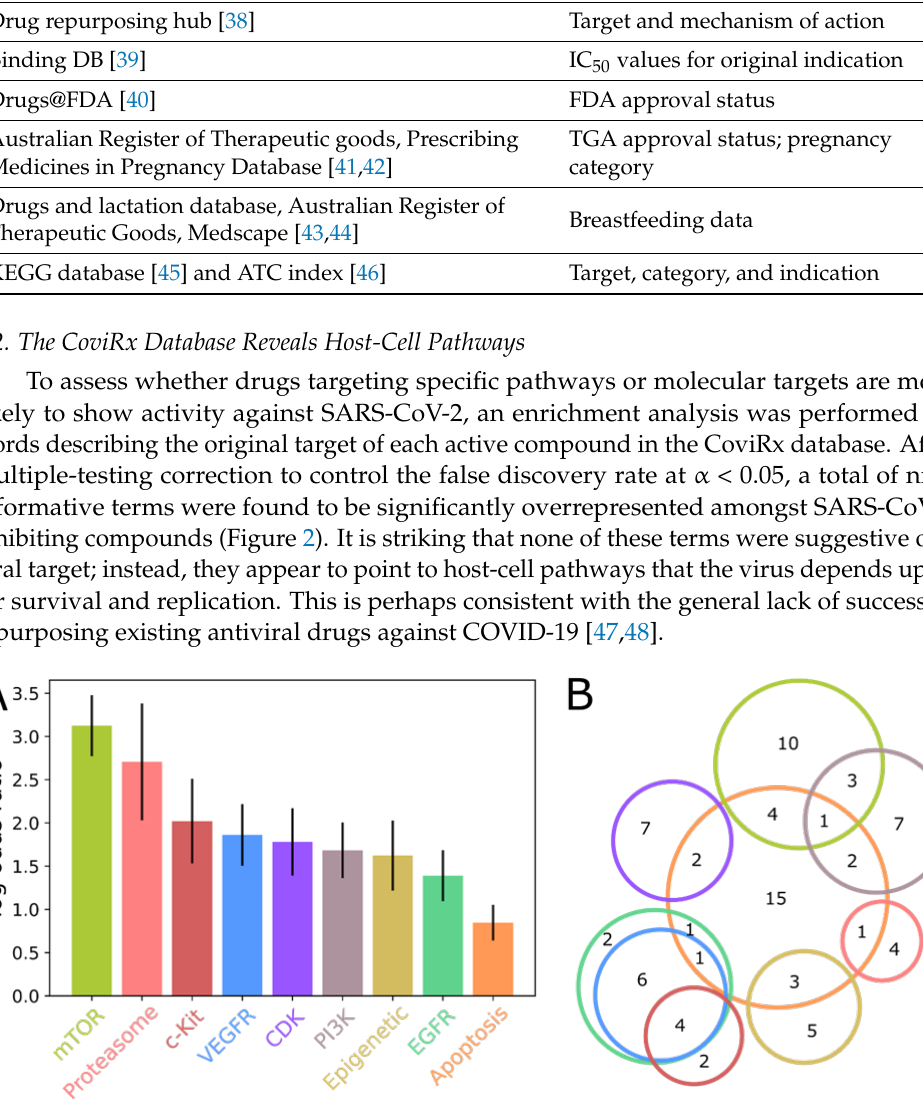
Figure 2. Enrichment analysis of molecular targets associated with SARS-CoV-2 activity. ( A ) The extent of enrichment, measured as log odds ratio, for nine targets significantly enriched in SARS- CoV-2 active compounds. ( B ) Venn diagram illustrating the degree of overlap amongst enriched targets. The colour scheme is shown in ( A ), and the number of active compounds contributing to each target combination is also